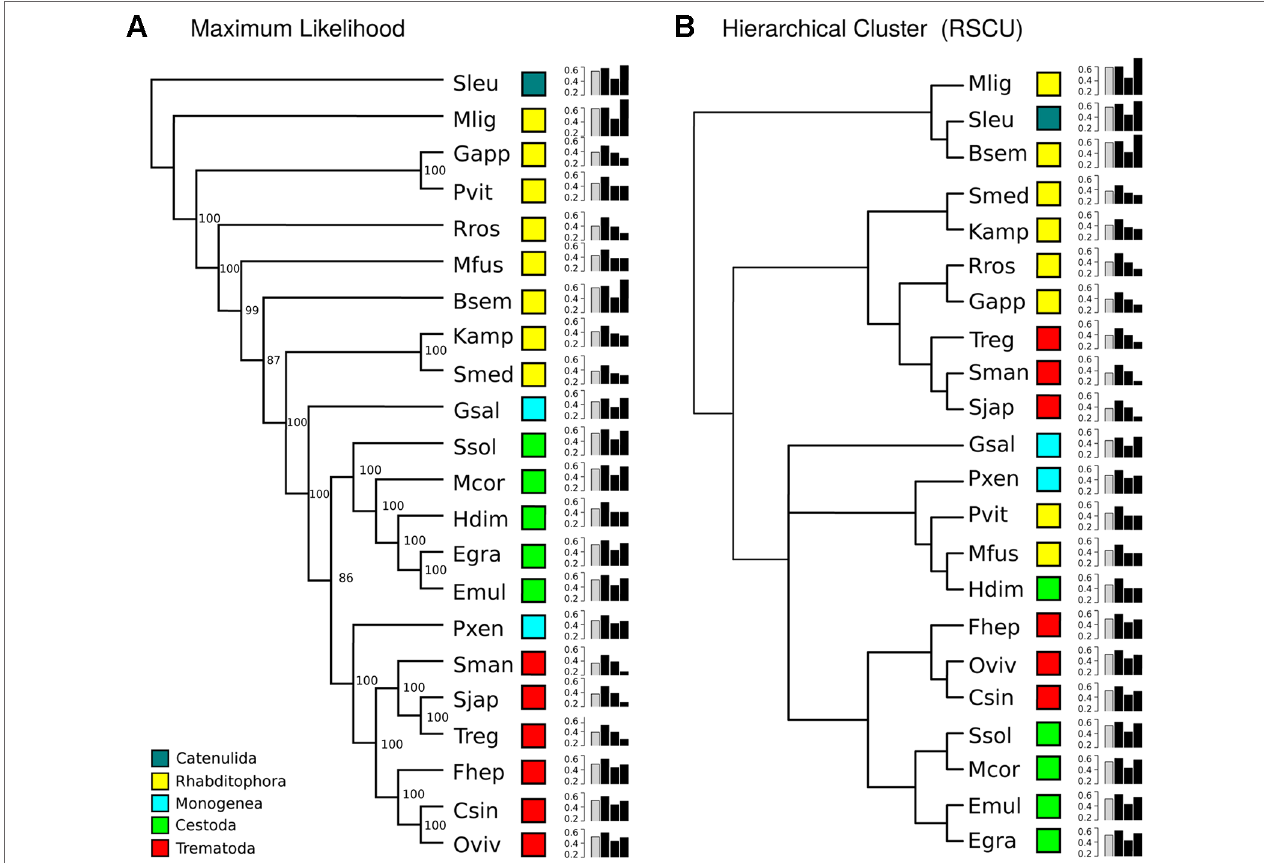
FIGURE 1 | GC composition variation across Platyhelminthes. (A) Maximum likelihood phylogenetic tree built with a set of 700 orthologue genes. Light blue, green, and red boxes correspond to the Neodermata species; blue and yellow boxes correspond to “turbellaria” species (see abbreviations in Table 1 ). SH-like support values are indicated for each node. (B) Hierarchical clustering based on GC content of relative synonymous codons (RSCU). Histograms reflect overall GC content in all orthologues (gray bar) and by codon position (black bars). GC3 is the most variable between